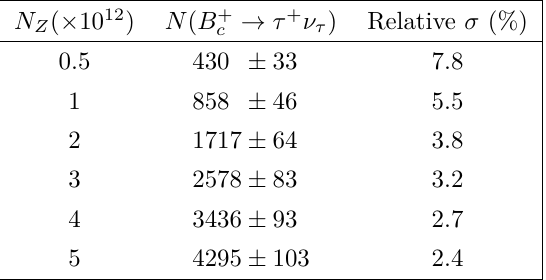
Table 1 . Estimated signal yields as a function of N Z , where the uncertainties quoted are statis- tical only. The yield central values are determined from the cut optimisation procedure, and the uncertainties from pseudoexperiment fits.